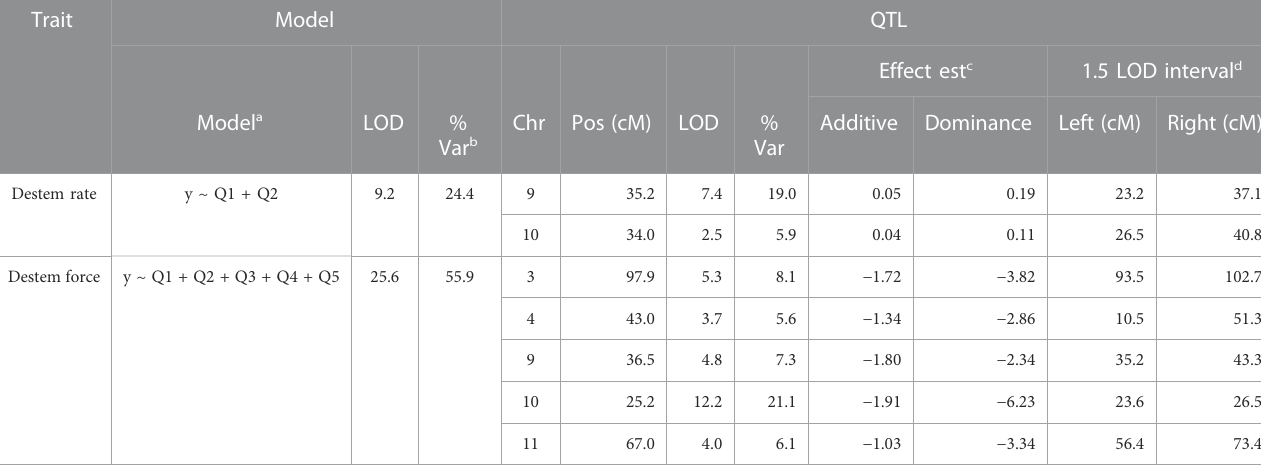
TABLE 3 Quantitative trait locus (QTL) models for destemming frequency and force from analysis based on 151 MUC14 F 3 families evaluated in 2019.